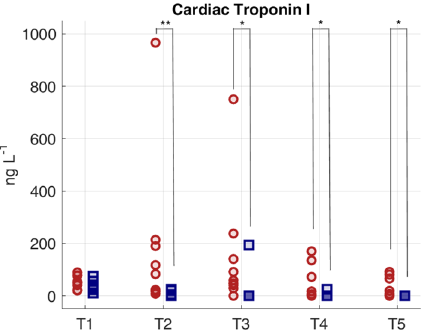
Figure 2. Values of high sensitive cardiac troponin I (hs-cTnI) concentration in arterial plasma at each time point of the experiment for both populations. Red circles represent septic animals, blue squares represent sham animals. Comparison between Sepsis and Sham: * p -value < 0.05, ** p -value < 0.01 (Wilcoxon rank sum test).